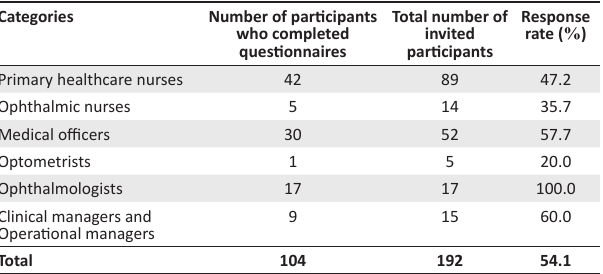
TABLE 1: Categories and number of participants to whom questionnaires were